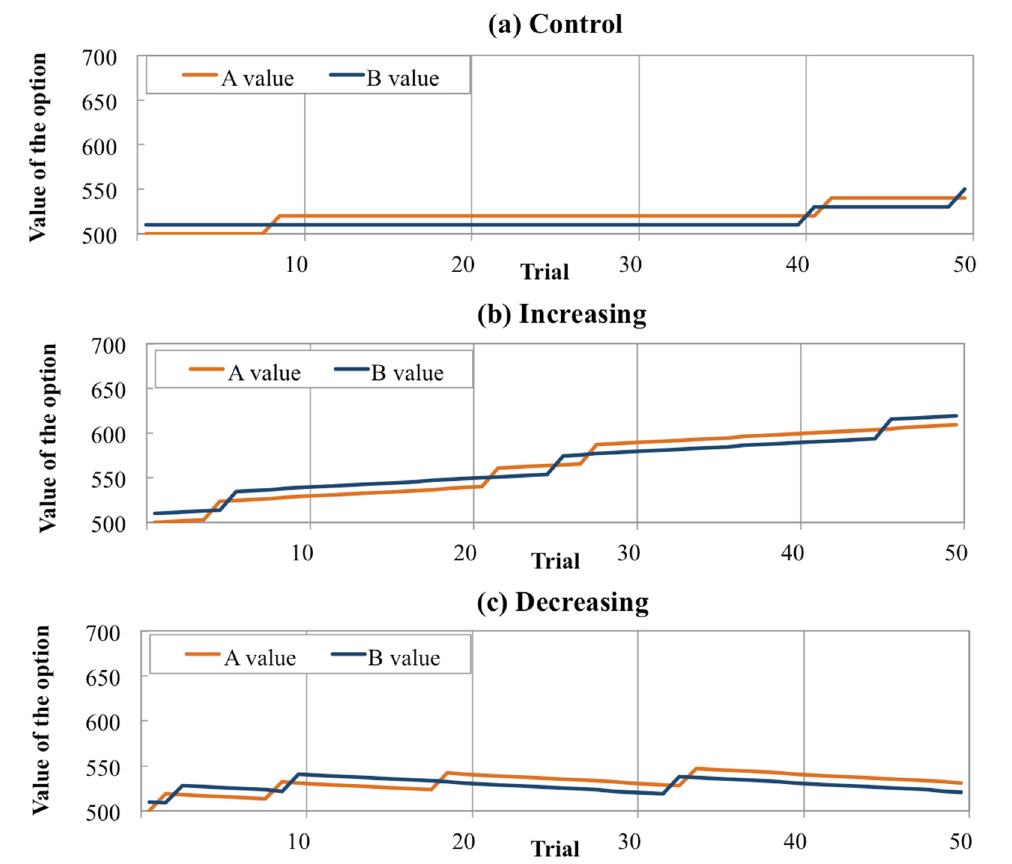
Figure 2. Examples for the number values of the two options in the experiment over the first 50 of 200 trials. In all experimental conditions, the lower value had a random chance of .10 to increase by 20 every trial. On top of this, there were global trends affecting both options in the increasing and decreasing condition. ( a ) There was no global trend in the control condition that corresponded to the standard leapfrog task; ( b ) In the increasing condition, both options increased their value by 1 every trial; ( c ) In the decreasing condition, both options decreased their value by 1 every